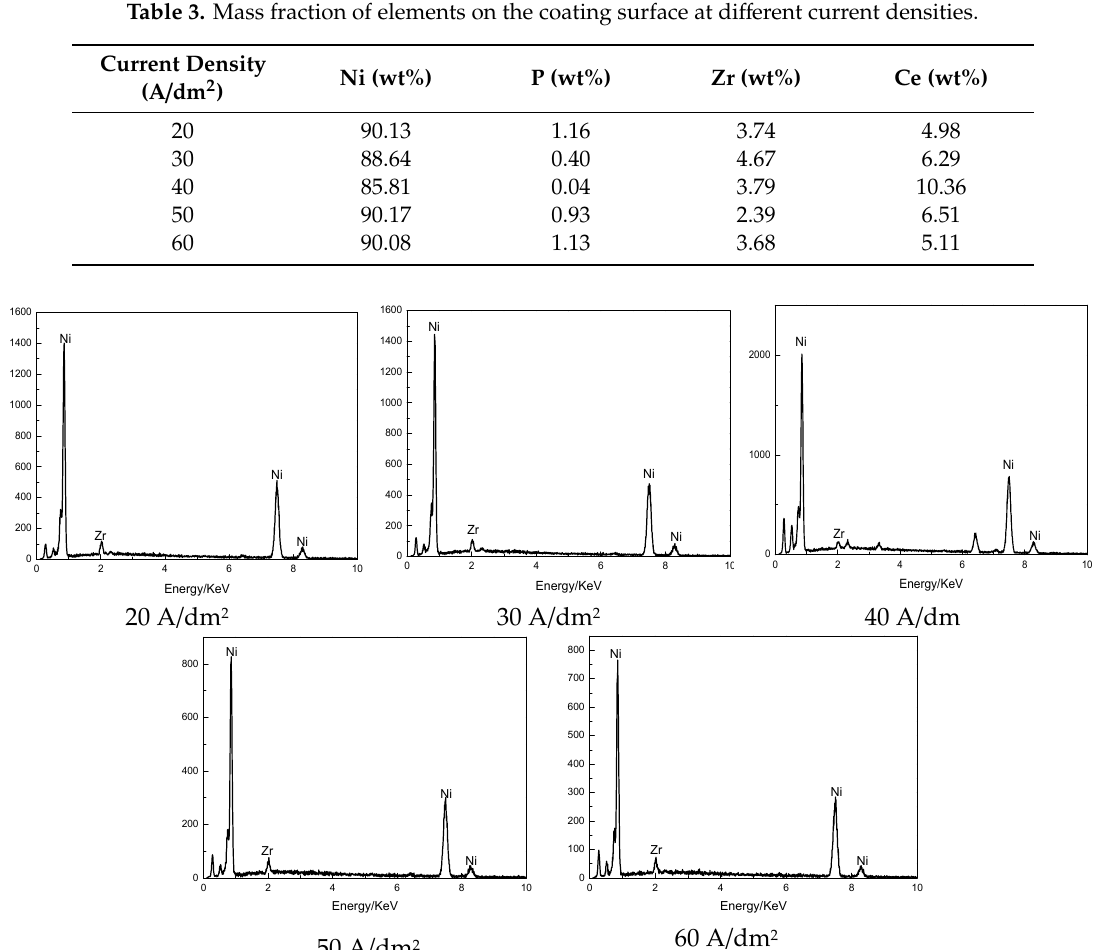
Figure 5. EDS spectra of Ni–P–-ZrO 2 -CeO 2 composite coatings prepared at different current densities.